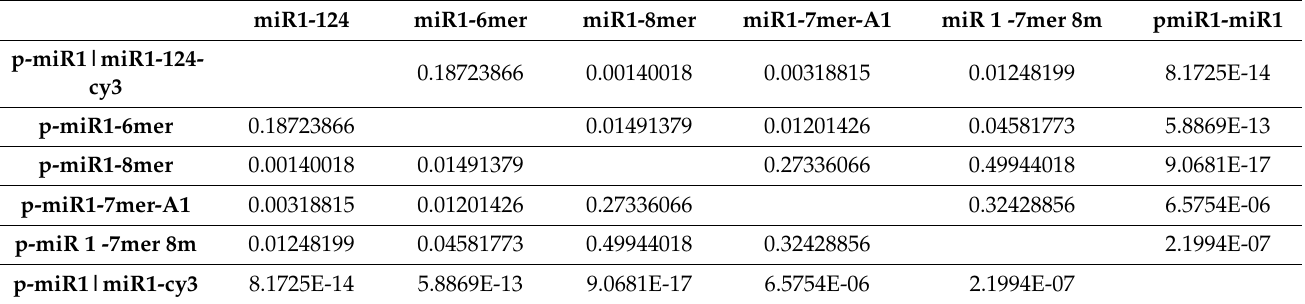
Table 4. Descriptive statistics for Figure 1D—modifications in p-miR1-GFP target sequences.